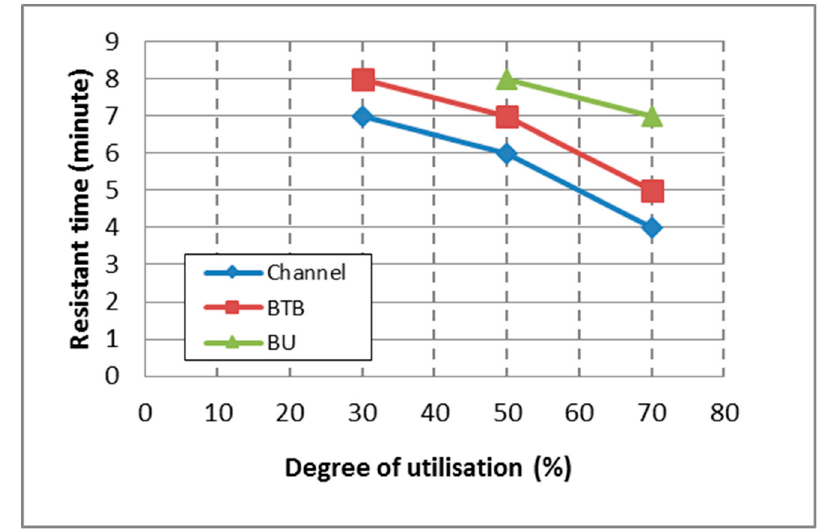
Figure 14. Effect of steel section type on fire resistance time.